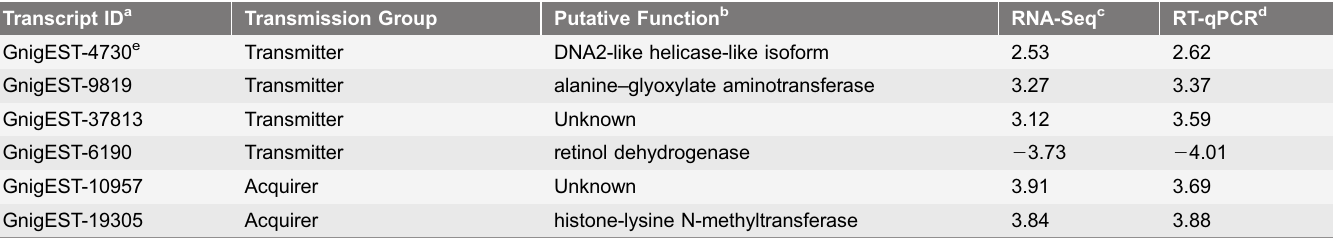
Table 1. Comparison of abundance for six differentially expressed transcripts in G. nigrifrons transmitters or acquirers relative to the healthy control using RNA-Seq and